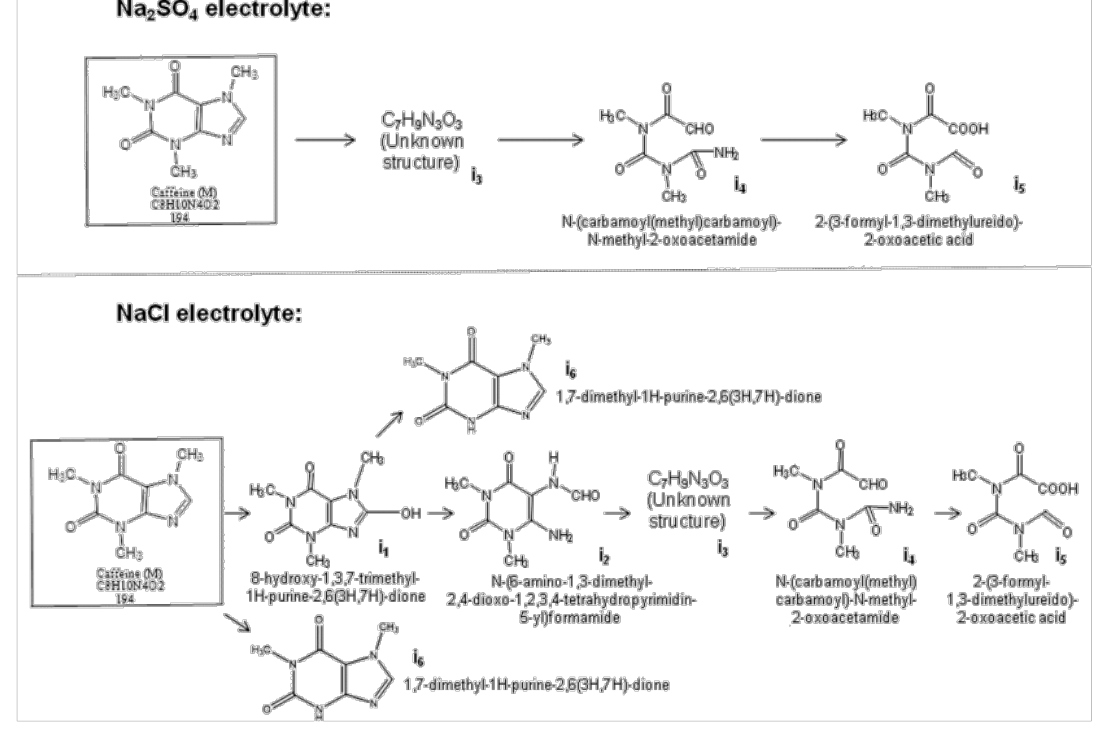
Figure 6. The mechanism model proposed for caffeine degradation by electrochemical oxidation with conductive-diamond electrodes using Na 2 SO 4 or NaCl as the electrolyte. Reprinted from Indermuhle et al. [97], copyright © (2013) with permission from Elsevier.